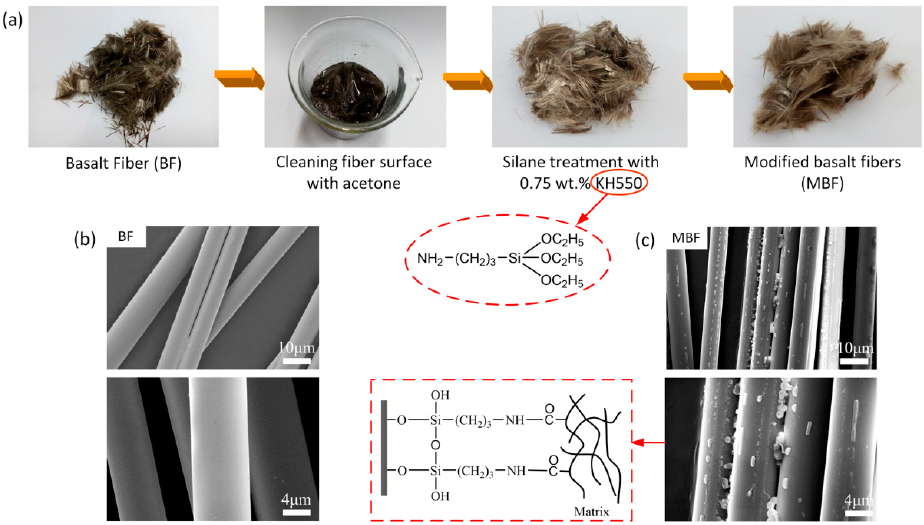
Figure 1. ( a ) The modification process of BF; ( b , c ) SEM micrograph of BF and